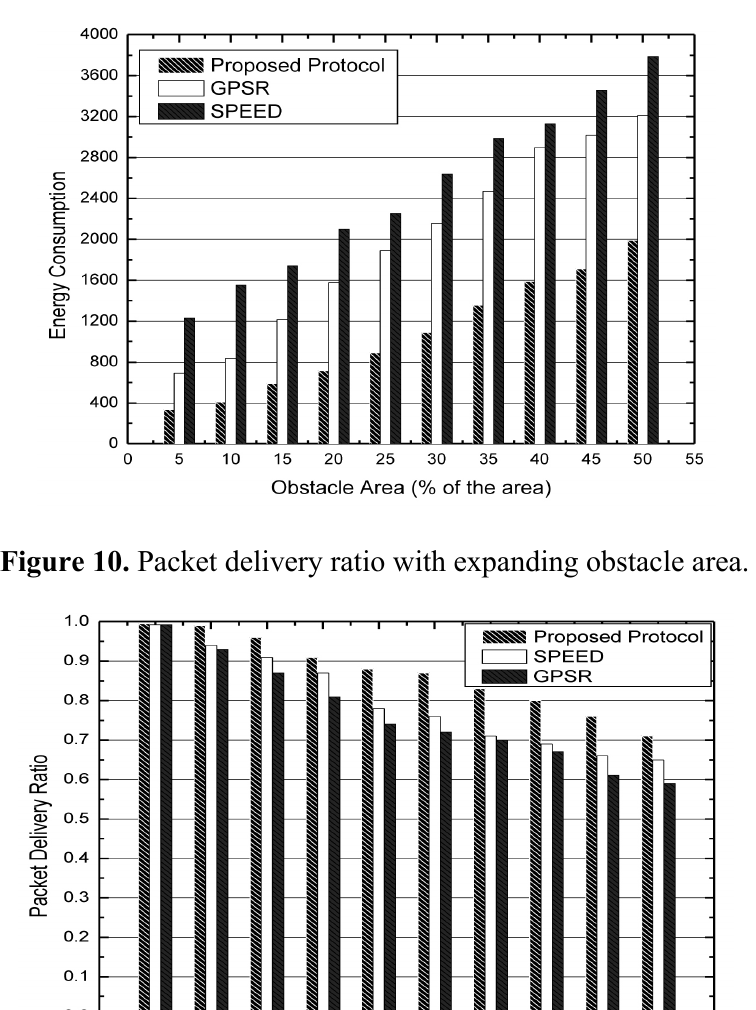
Figure 9. Energy consumption with expanding obstacle area.